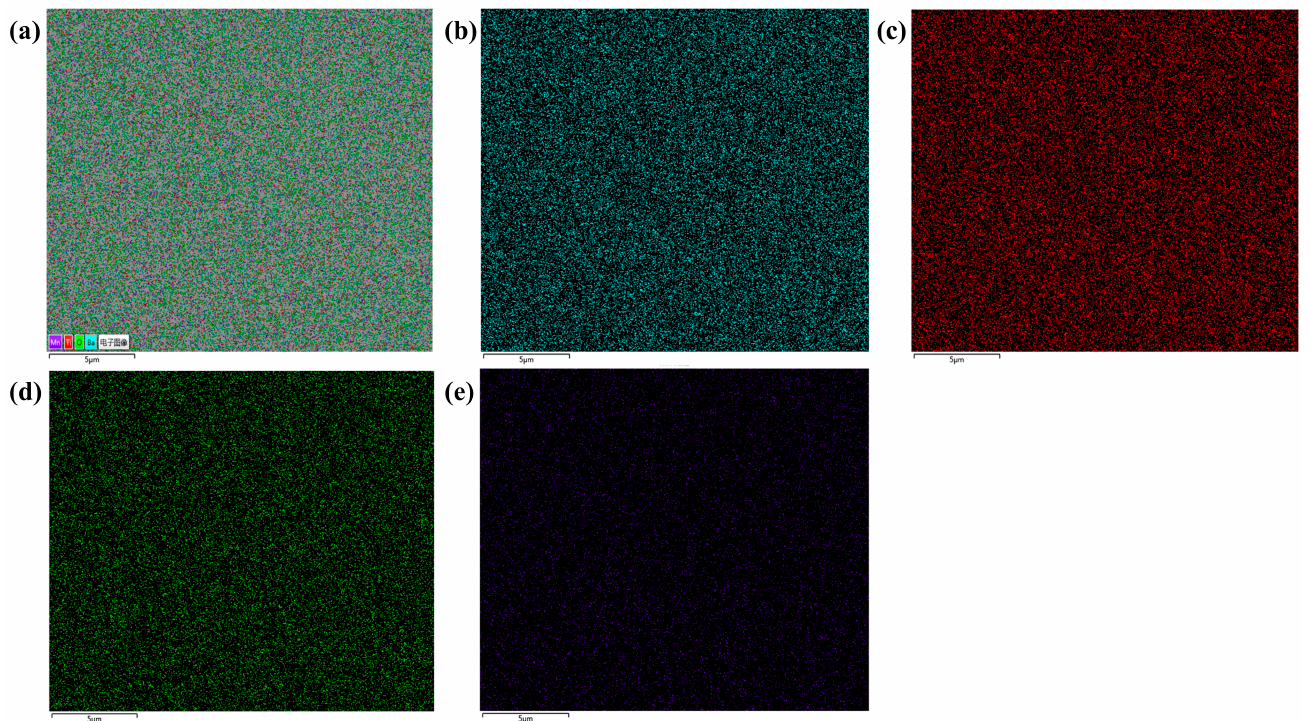
Figure 4. BT-8% Mn thin film annealed at 640 °C EDS spectrum: ( a ) element distribution map; ( b ) Ba;